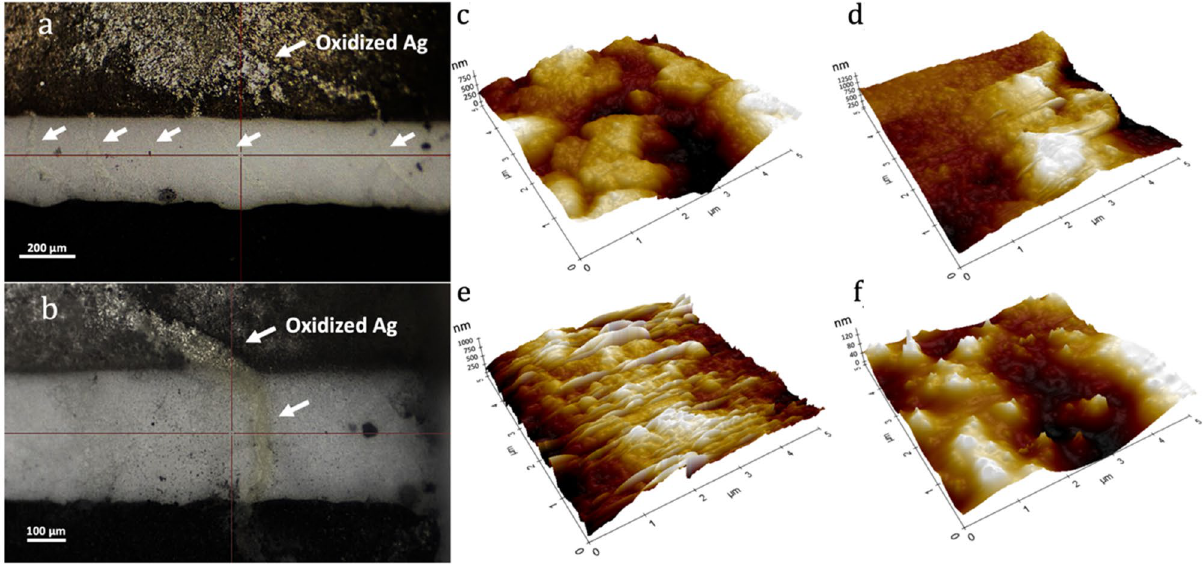
Figure 4. The evidence of CFs, taken after the CV measurement for ( a ) 1BOBzBT 2 :3CHCl 3 -sensor and, ( b ) 3BOBzBT 2 :5CHCl 3 -sensor. AFM-3D images of the bare carbon WE ( c ), after drop casting BOBzBT 2 dilution onto the WE ( d ), 1BOBzBT 2 :3CHCl 3 -modified WE and 3BOBzBT 2 :3CHCl 3 -modified WE after performing the CV measurements ( e and f ,